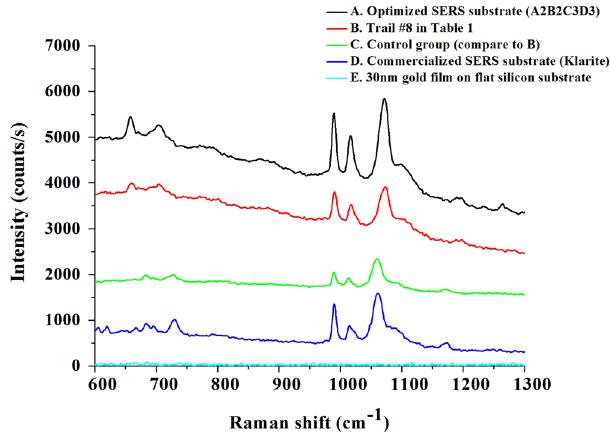
Figure 2. Raman spectrum of 10 − 2 M S.A.M. thiophenol molecules measured from different kinds of SERS substrates (labeled with different colors in the figure). All measurement are conducted under the same laser and surrounding conditions.